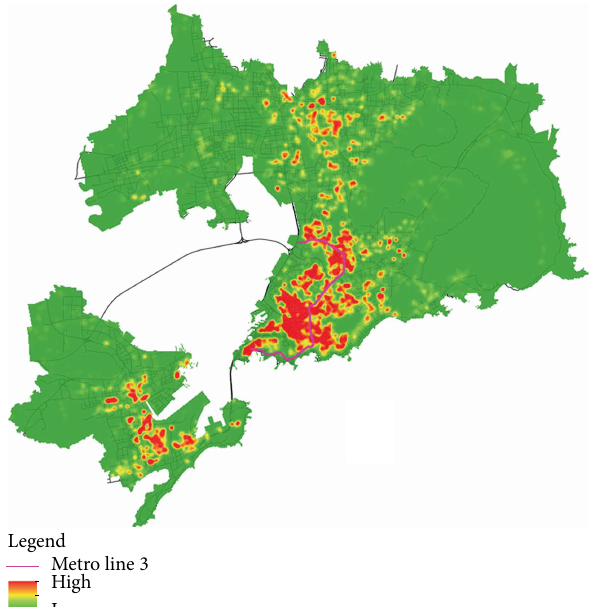
Figure 11: Distribution of jobs in urban